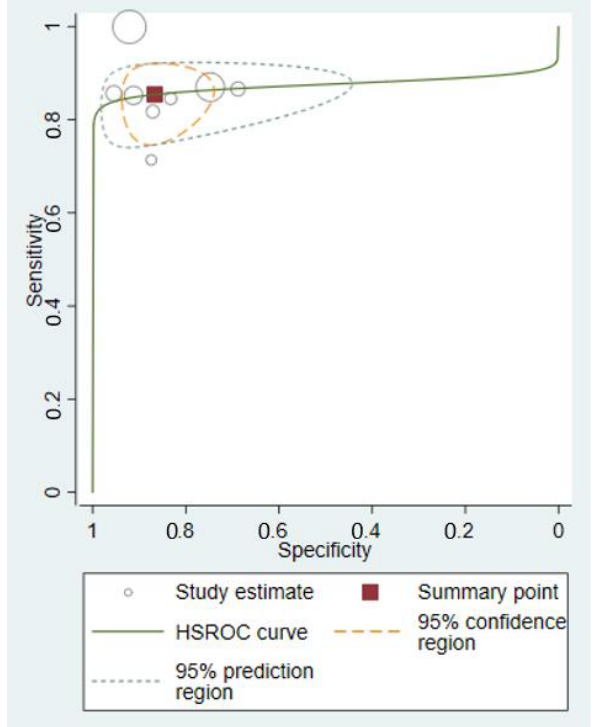
Figure 6. Hierarchical summary receiver-operating characteristic curve (HSROC).